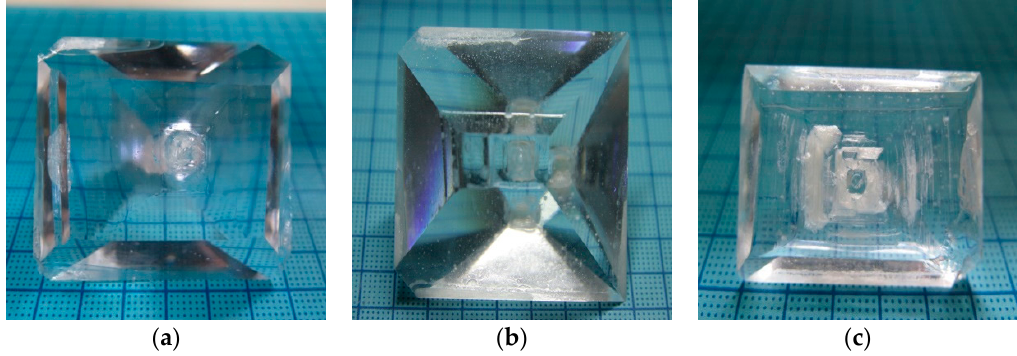
Figure 1. Photos of as-grown crystals: ( a ) undoped CLBO; ( b ) 2.5% Al-doped CLBO; ( c ) 5% Al-doped CLBO.